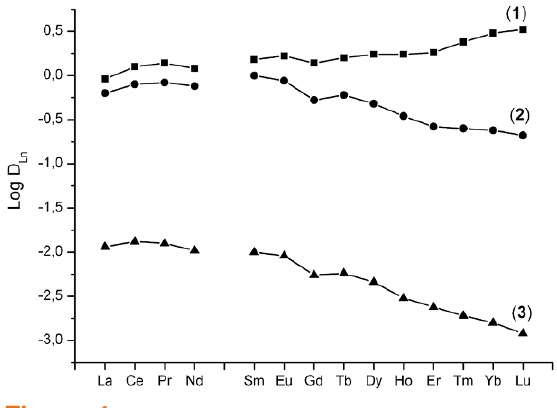
Figure 1. The extraction of lanthanides(III) from 4 M NH with solutions of compounds 1-3 in 1,2-dichloroethane. Initial extractant concentrations are 0.00333 M (compound 1 ), 0.005 M (compound 2 ) and 0.01 M (compound 3 ).